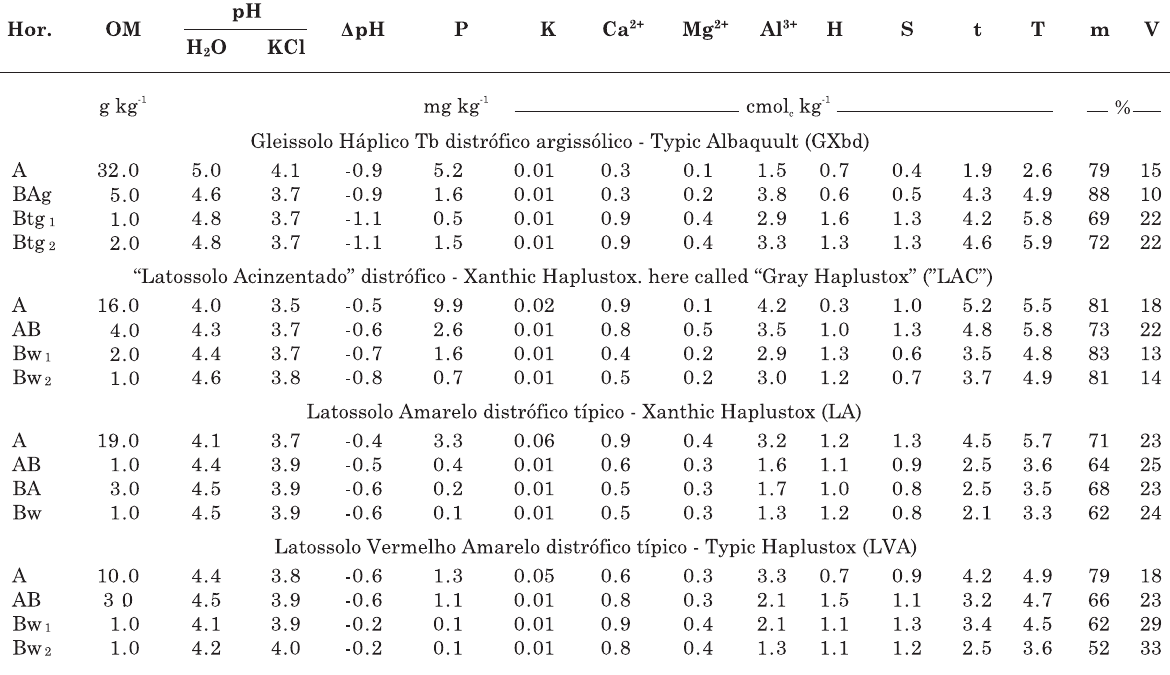
Table 3. Soil chemical attributes in the toposequence on the slope of the Lagoa do Leandro